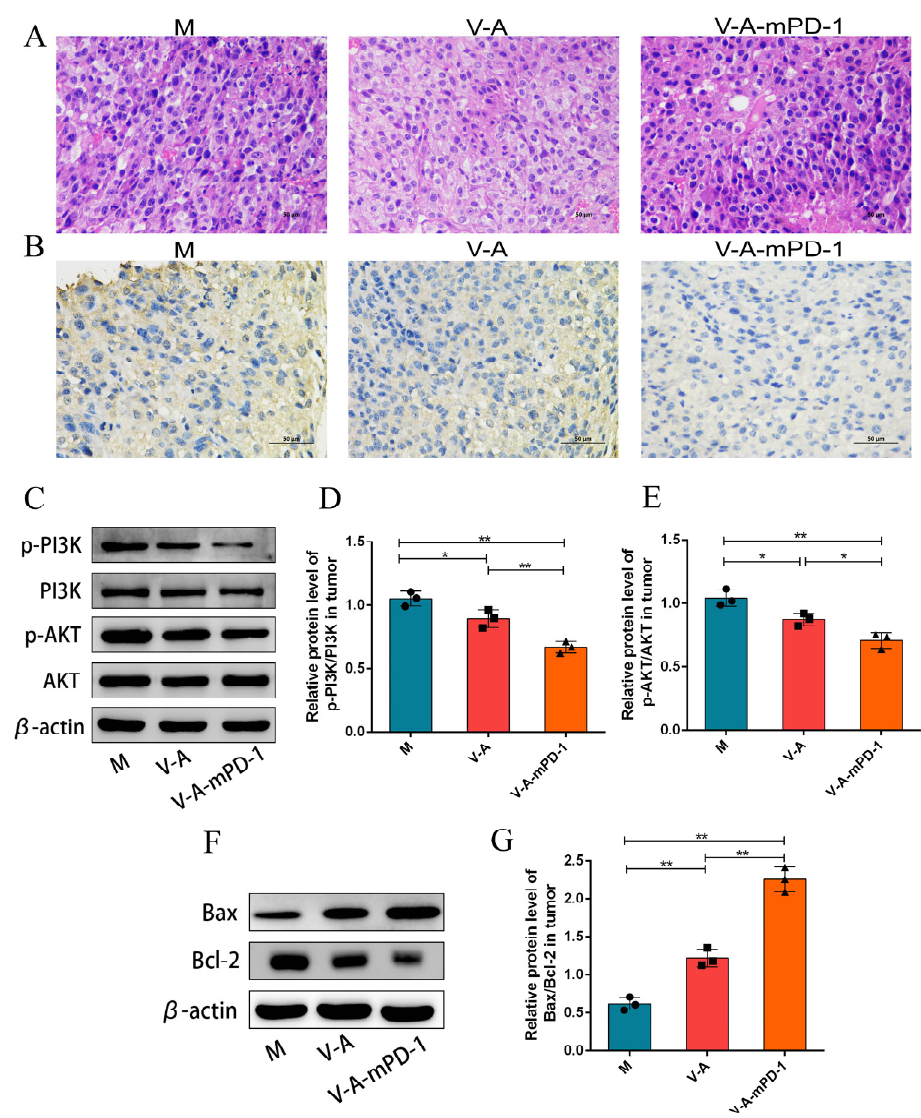
Figure 4. V ‐ A ‐ mPD ‐ 1 exerts tumor ‐ killing effects by inducing apoptosis. ( A ) H&E staining images Figure 4. V-A-mPD-1 exerts tumor-killing effects by inducing apoptosis. ( A ) H&E staining images of of tumor tissues (400×); ( B ) Immunohistochemistry of VEGF expression was determined in mela ‐ tumor tissues (400 × ); ( B ) Immunohistochemistry of VEGF expression was determined in melanoma noma tumors (400×); ( C ) p ‐ PI3K, PI3K, p ‐ AKT and AKT expressions were analyzed using Western tumors (400 × ); ( C ) p-PI3K, PI3K, p-AKT and AKT expressions were analyzed using Western blotting blotting on the tumors; Relative expressions of ( D ) p ‐ PI3K, PI3K and ( E ) p ‐ AKT, AKT in ( C ); ( F , G ) on the tumors; Relative expressions of ( D ) p-PI3K, PI3K and ( E ) p-AKT, AKT in ( C ); ( F , G ) Relative Relative expression of Bax/Bcl ‐ 2 was analyzed by Western blotting in tumors. M, the melanoma model group; V ‐ A, the V ‐ A treatment group; V ‐ A ‐ mPD ‐ 1, the V ‐ A ‐ mPD ‐ 1 treatment group. One ‐ expression of Bax/Bcl-2 was analyzed by Western blotting in tumors. M, the melanoma model group; way ANOVA and Tukey’s multiple comparison for D, E, and G. Data are presented as means ± SD V-A, the V-A treatment group; V-A-mPD-1, the V-A-mPD-1 treatment group. One-way ANOVA and ( n = 3). * p < 0.05, ** p < 0.01. Tukey’s multiple comparison for D, E, and G. Data are presented as means ± SD ( n = 3). * p < 0.05, ** p <